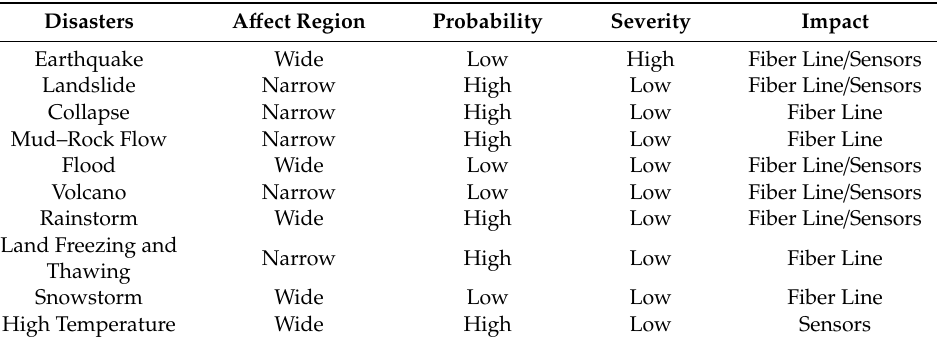
Table 5. The characteristics of di ff erent kinds of natural